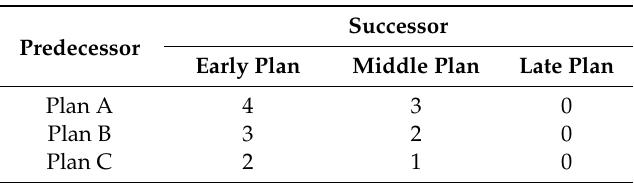
Table 3. Influence Table 3. Influence matrix.